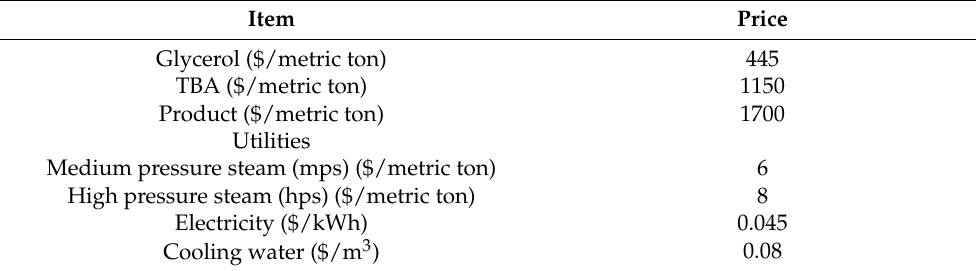
Table 7. Materials and utility costs for glycerol etherification process